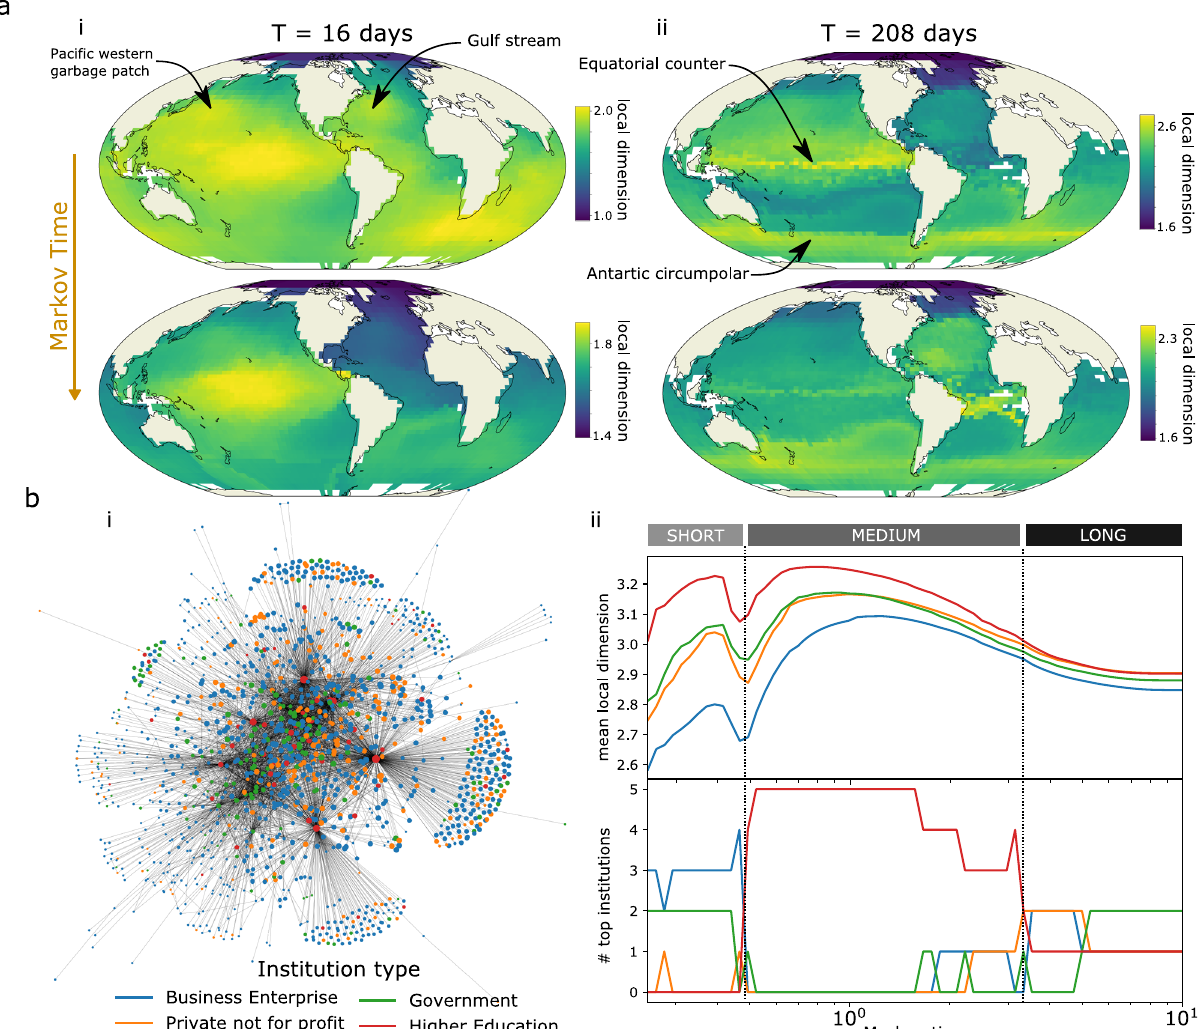
Fig. 6 Illustration of local dimension at several scales in two dataset. In a , we considered two graphs extracted from the ocean drifter by ref. 29 where edges are the number of drifters crossing two regions of the ocean within i T = 16 and ii 208 days. For each, we selected a small and a large scale of local dimension, each representing various known features of the ocean dynamics, mostly located between the main gyres such as between the north and south equatorial in the paci fi c, or along the antarctic circumpolar current. In b , we explored a i social network of scienti fi c collaborations between New Zealand institutions ii across scales, to fi nd that the top 5 institutions are businesses at small scales, universities at longer scales, and a mix of institutions at stationarity. From middle scales, the University of Auckland remains the top-ranked node until